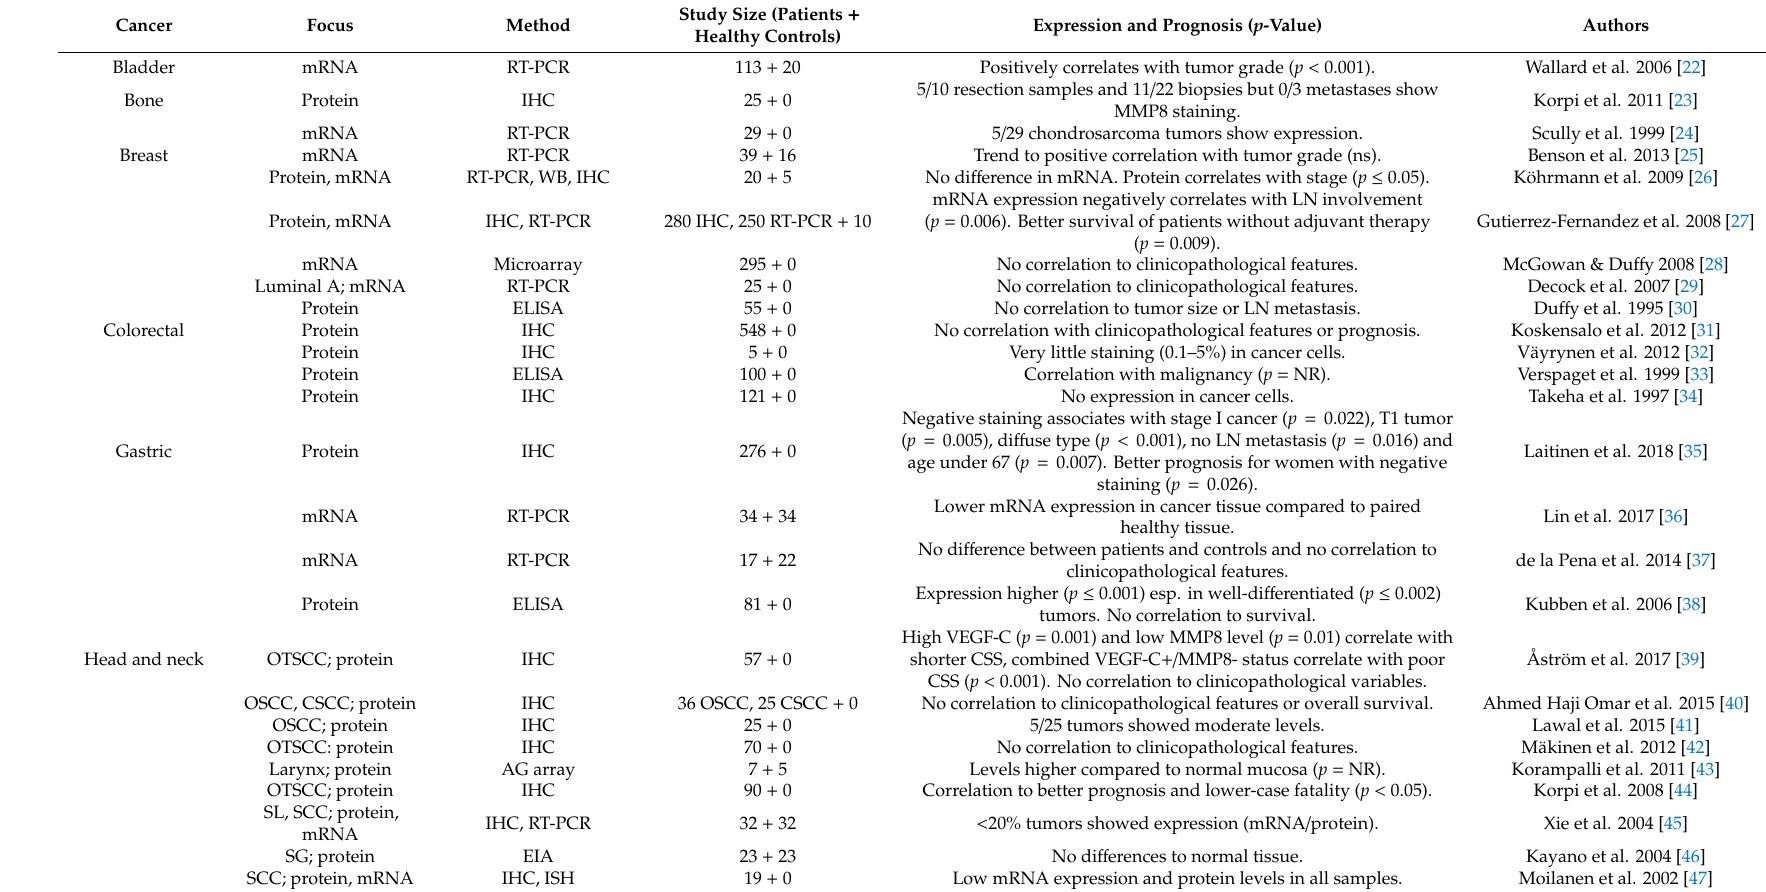
Table 1. Tumoral matrix metalloproteinase 8 expression and